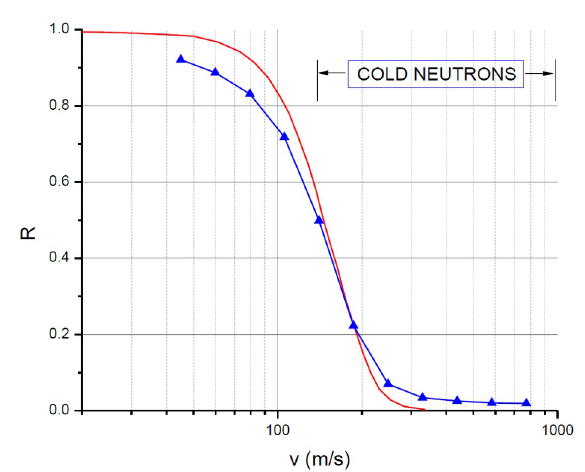
Fig. 6 : Reflectivity vs. neutron velocity, for a 10 mm thick ND sample. The continuous line (red) is the result from Ref. [4], while the curve with symbols (blue) corresponds to our calculation (density = 0.6 g/cm 3